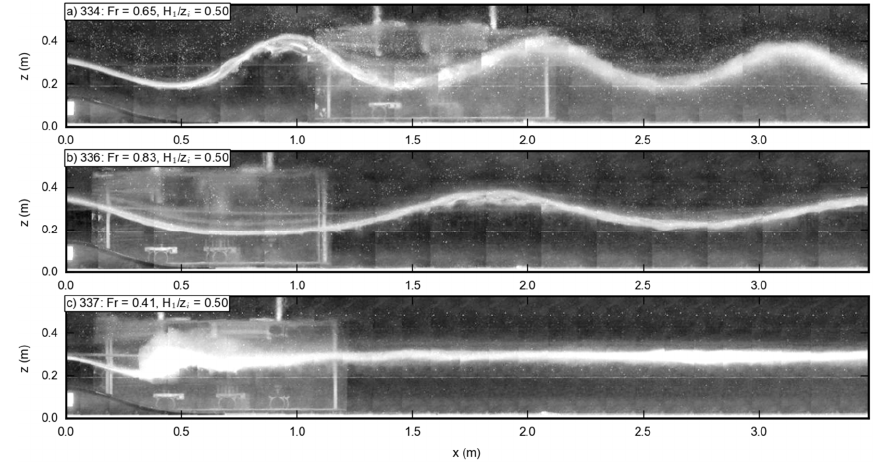
Figure 4. Examples of prototype flow regimes: ( a ) trapped lee wave; ( b ) long waves; ( c ) hydraulic jump.